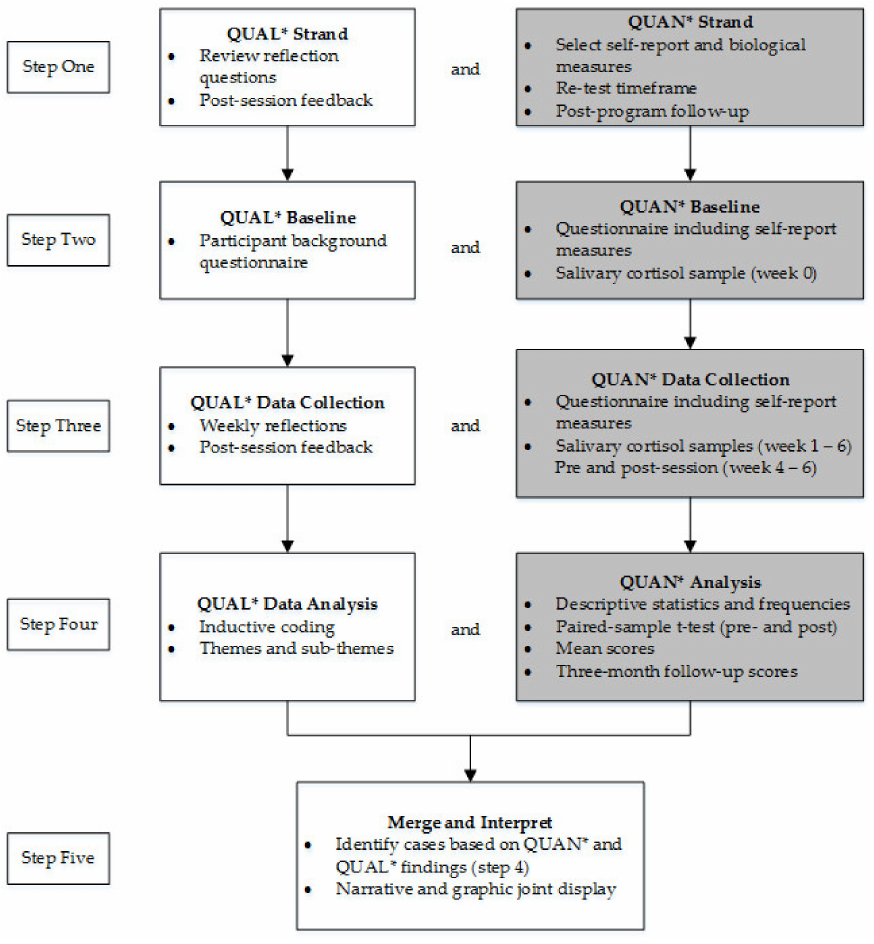
Figure 1. Study design flow chart; QUAL*—qualitative,